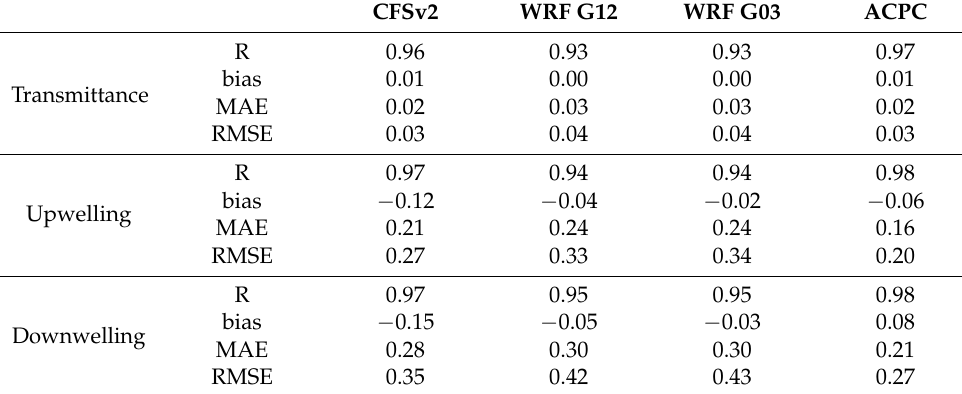
Table 3. Statistical metrics of atmospheric parameters estimated from different atmospheric profiles.